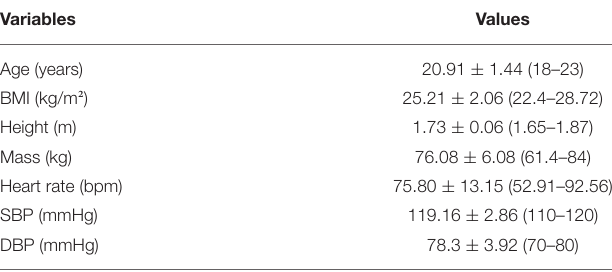
TABLE 1 | Mean values followed by their respective standard deviations (minimum and maximum) of age, mass, height, BMI, heart rate, SBP and